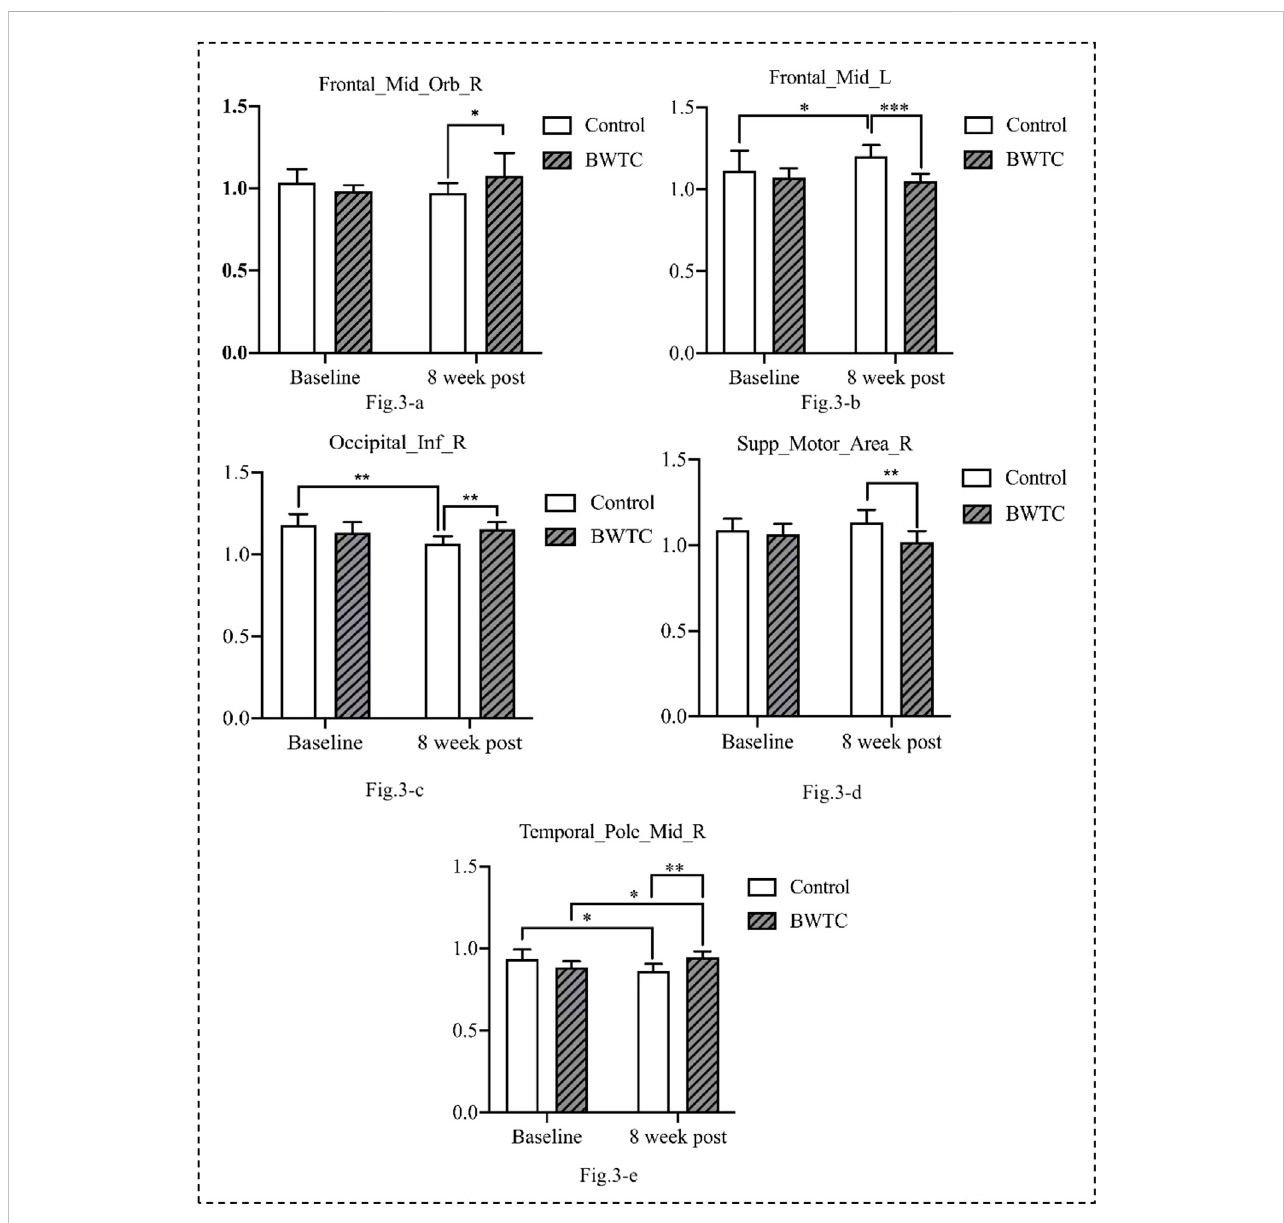
FIGURE 3 The differences between the groups before and after the intervention in the same brain